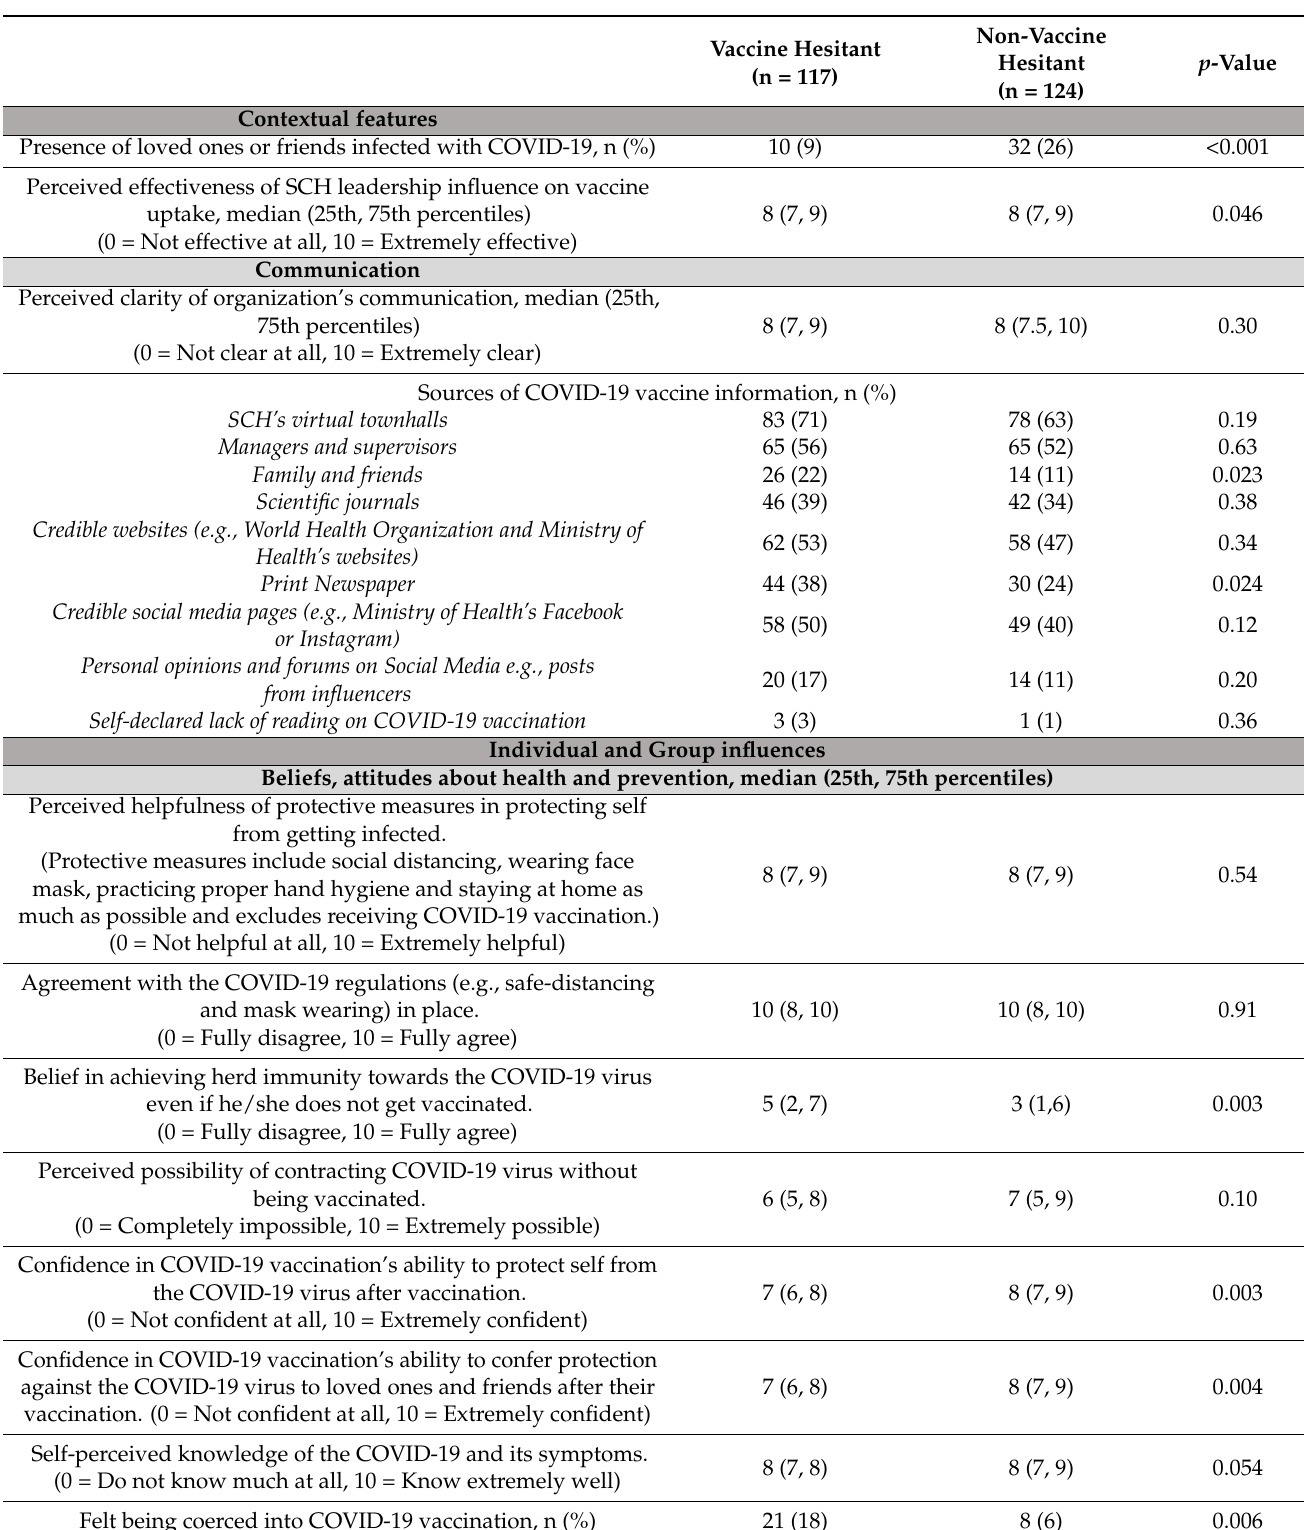
Table 2. Vaccine hesitancy